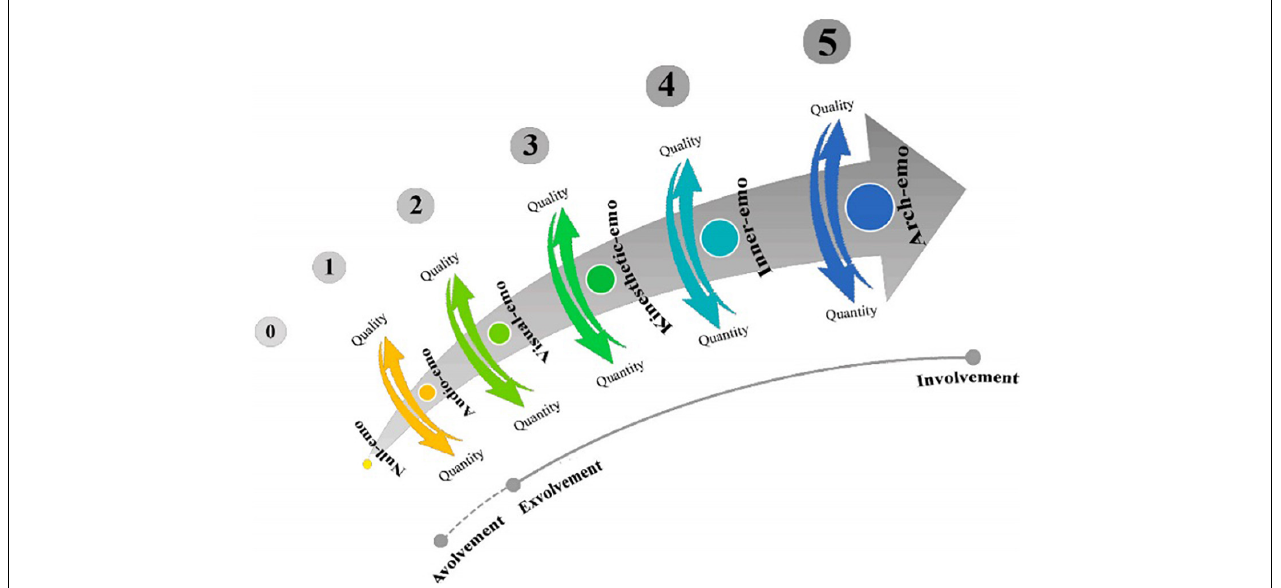
FIGURE 2 | Emotioncy levels (Reprinted with permission from “Emotioncy, extraversion, and anxiety in willingness to communicate in English,” by Pishghadam, 2016, Proceedings of the 5th International Conference on Language, Education, and Innovation. London, United Kingdom).